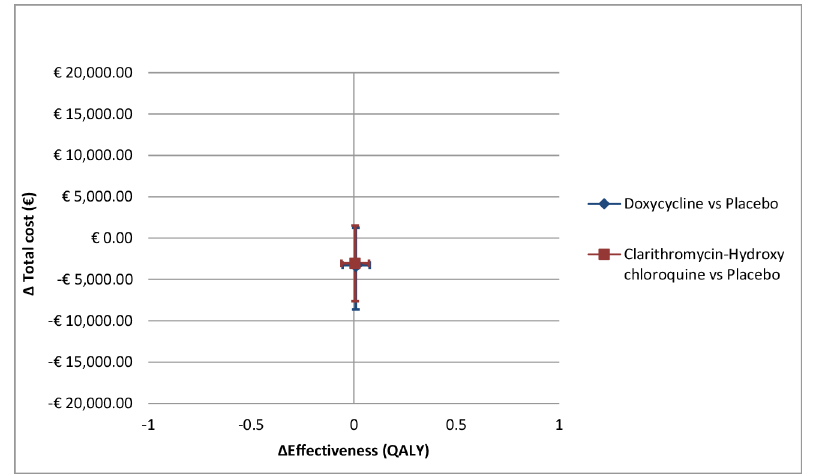
Fig 1. Incremental total costs plotted against incremental QALYs with 95% confidence intervals.